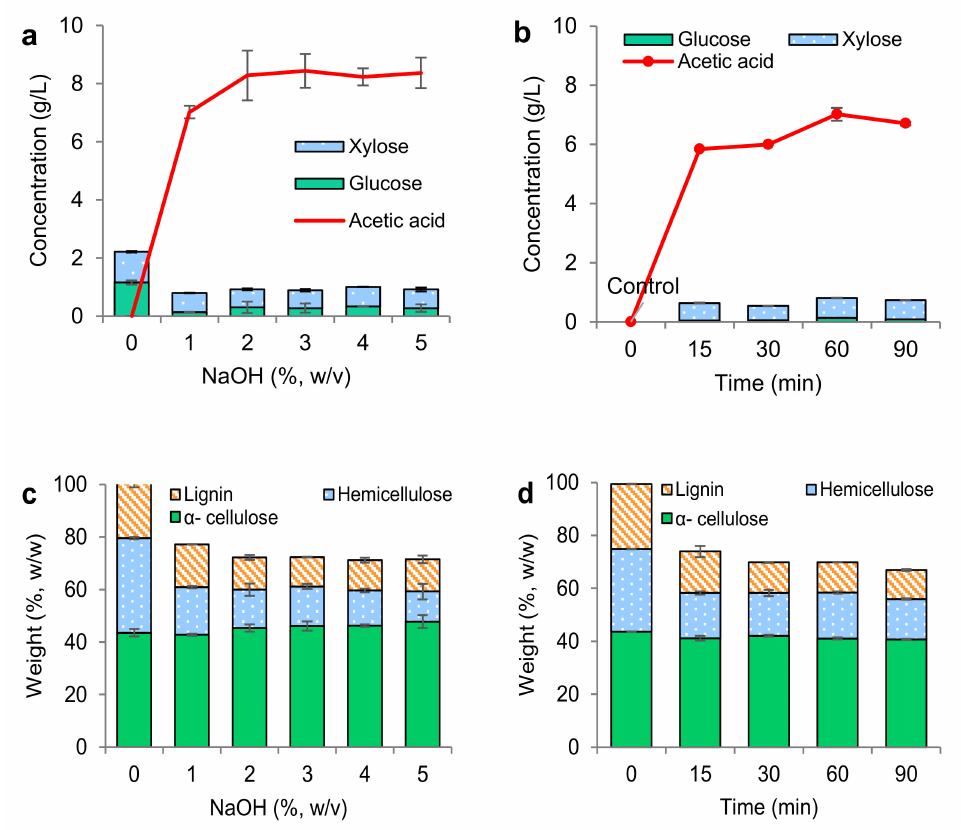
Figure 2. Composition of the soluble and insoluble fractions of OPT biomass on sugars and acetic acid released in the liquor, and the chemical composition after deacetylation (calculated based on weight recovery); ( a , c ) effect of different NaOH loadings; ( b , d ) effect of different reaction